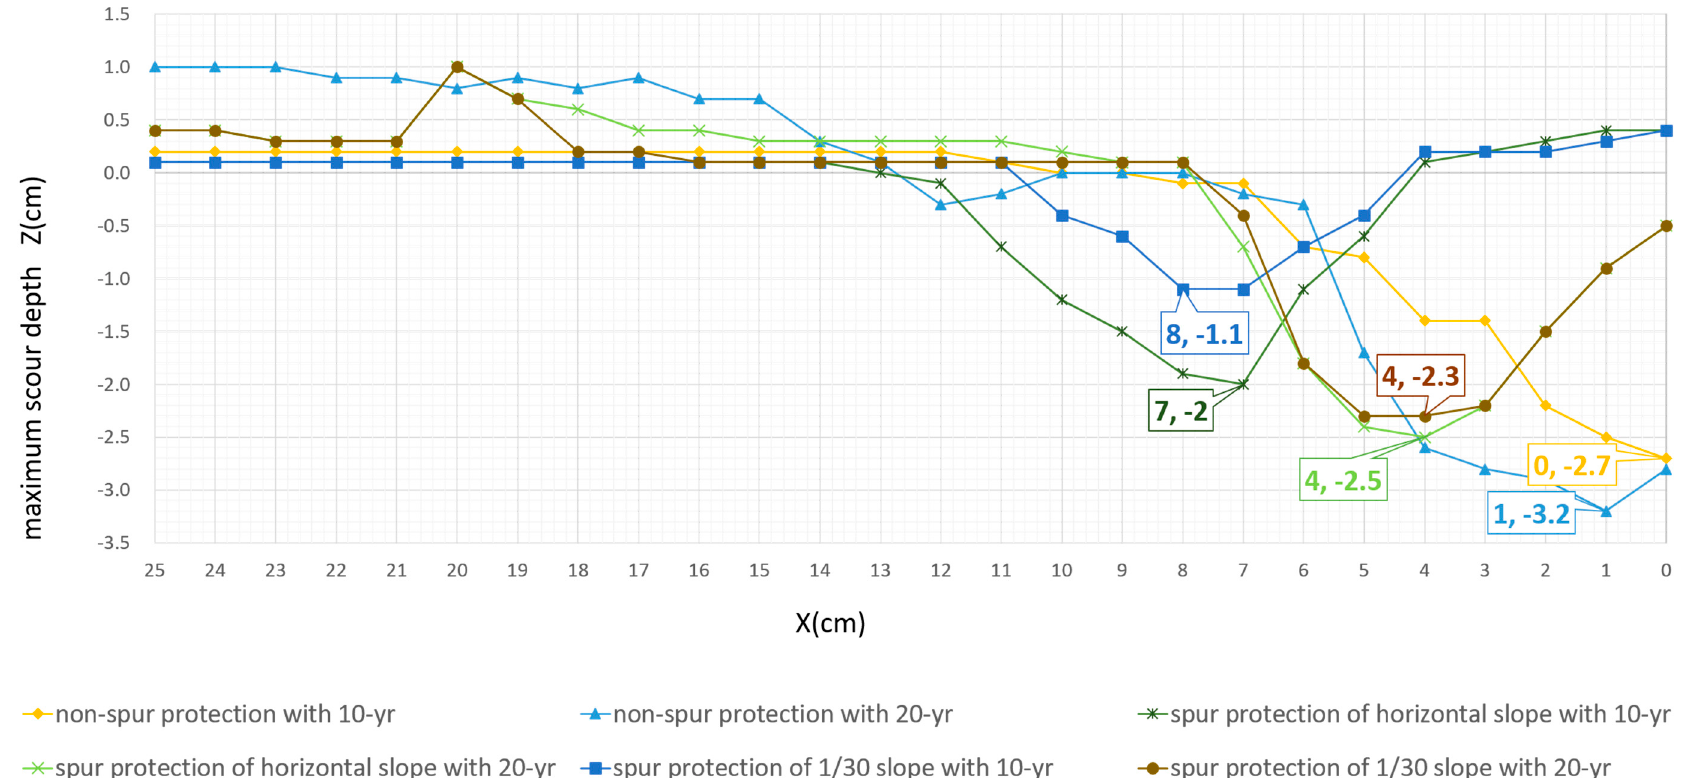
Figure 12. The maximum scour position of cross section with and without spur protections.